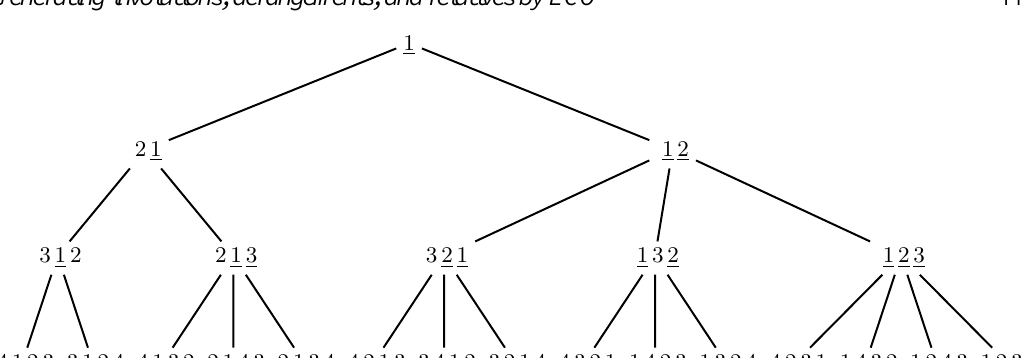
Fig. 2: The first four levels of the generating tree for Bell permutations. It is simply the restriction to Bell permuta- tions of the generating tree for unrestricted permutations in Figure 1(a). The tails of each permutation are underlined.